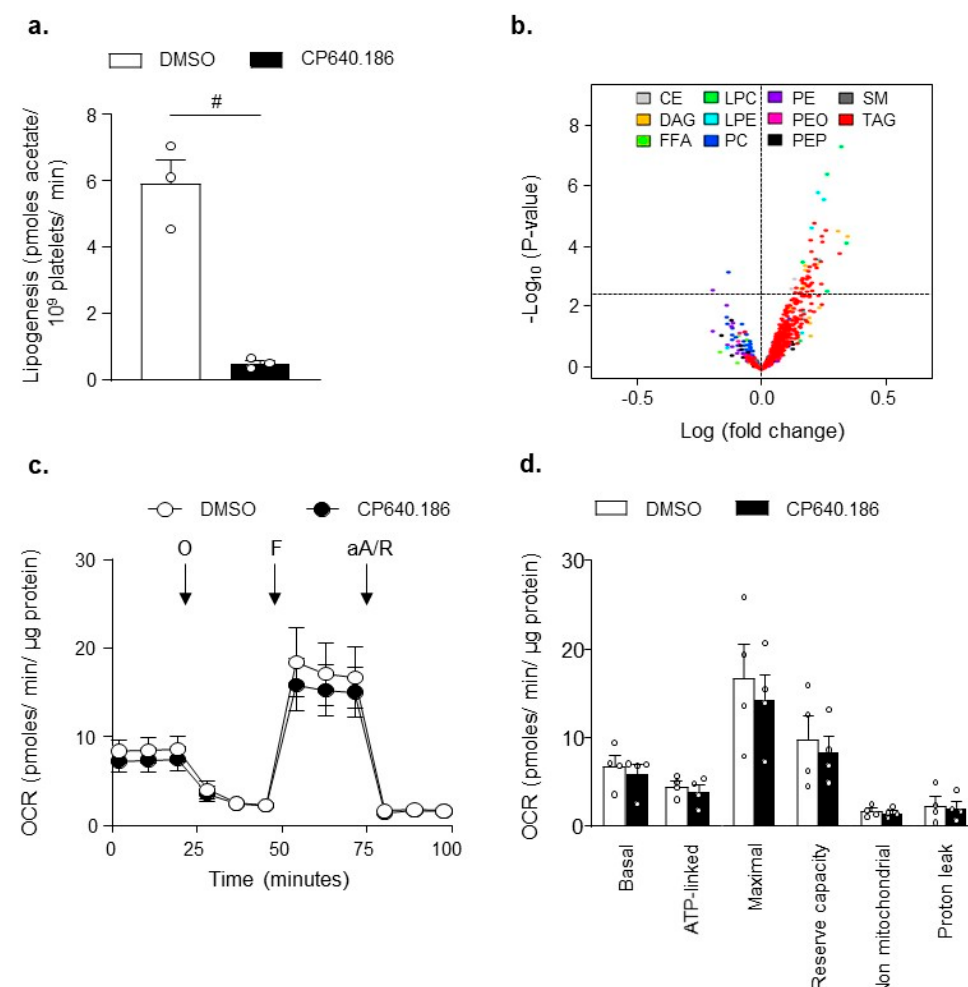
Figure 1. ACC inhibition induced by CP640.186 does not reduce overall lipid content and preserves mitochondrial function. ( a ) Washed human platelets were incubated with [1 − 14 C] − acetic acid for 2 h in the presence of dimethyl sulfoxide (DMSO) or CP640.186 (60 µM). Radioactivity incorporation into lipid fractions was determined. Data were expressed as means ± SEM ( n = 3); # p -value ≤ 0.0001 as compared to DMSO condition. Data underwent unpaired t-test. ( b ) Washed human platelets were preincubated with DMSO or CP640.186 (60 µM) before lipid extraction. Volcano plot representation of 672 detected lipid species. Lipids above the horizontal dotted line were up (right) − or down (left) − regulated with significant adjusted p -values ≤ 0.05. Log fold-changes and adjusted p -values were calculated from the multivariate regression model. CE = cholesterol ester; DAG = diacylglyc- erol; FFA = free fatty acid; LPC = lysophosphatidylcholine; LPE = lysophosphatidylethanolamine; PC = phosphatidylcholine; PE = phosphatidylethanolamine; PEO = plasmanyl phosphatidylethano- lamine; PEP = plasmalogen phosphatidylethanolamine; SM = sphingomyelin; TAG = triacylglycerol. ( c , d ) Oxygen consumption rate (OCR) was measured in washed human platelets preincubated for 2 h with DMSO or CP640.186 before bioenergetic measurements. OCR was assessed under basal condition and after treatment with 1 µM oligomycin (O), 0.45 µM carbonyl cyanide p-trifluorometh- oxyphenylhydrazone (F), and a mix of 1µM antimycin A (aA) and 1µM rotenone (R). ( c ) OCR profile is shown. ( d ) Mitochondrial function was evaluated by calculating basal, ATP-linked, maximum, non-mitochondrial OCR, reserve capacity, and proton leak. Results were expressed as means ± SEM ( n = 4). The data were analyzed using unpaired t − test.